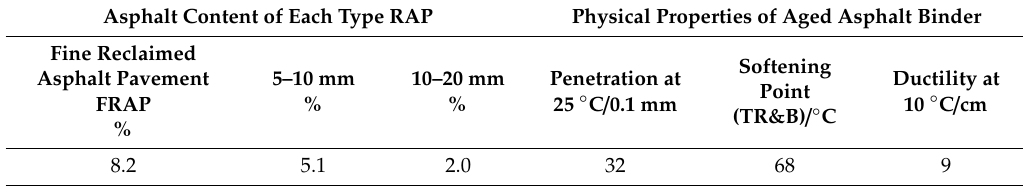
Table 2. Asphalt content and physical properties of aged asphalt binder among reclaimed asphalt pavement